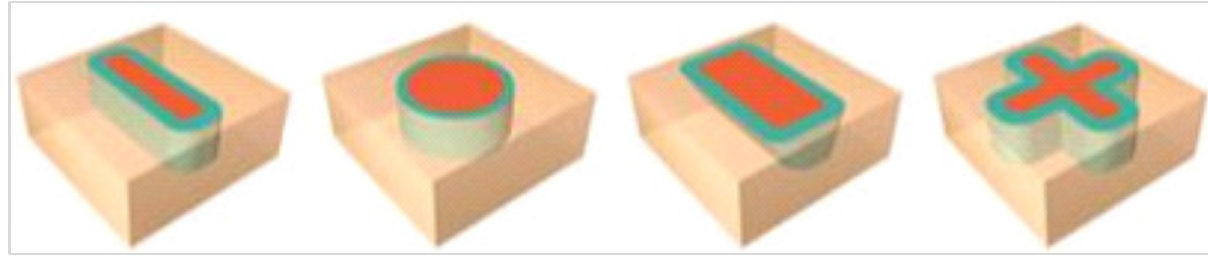
Figure 2. The manual dexterity exercises used in the study.